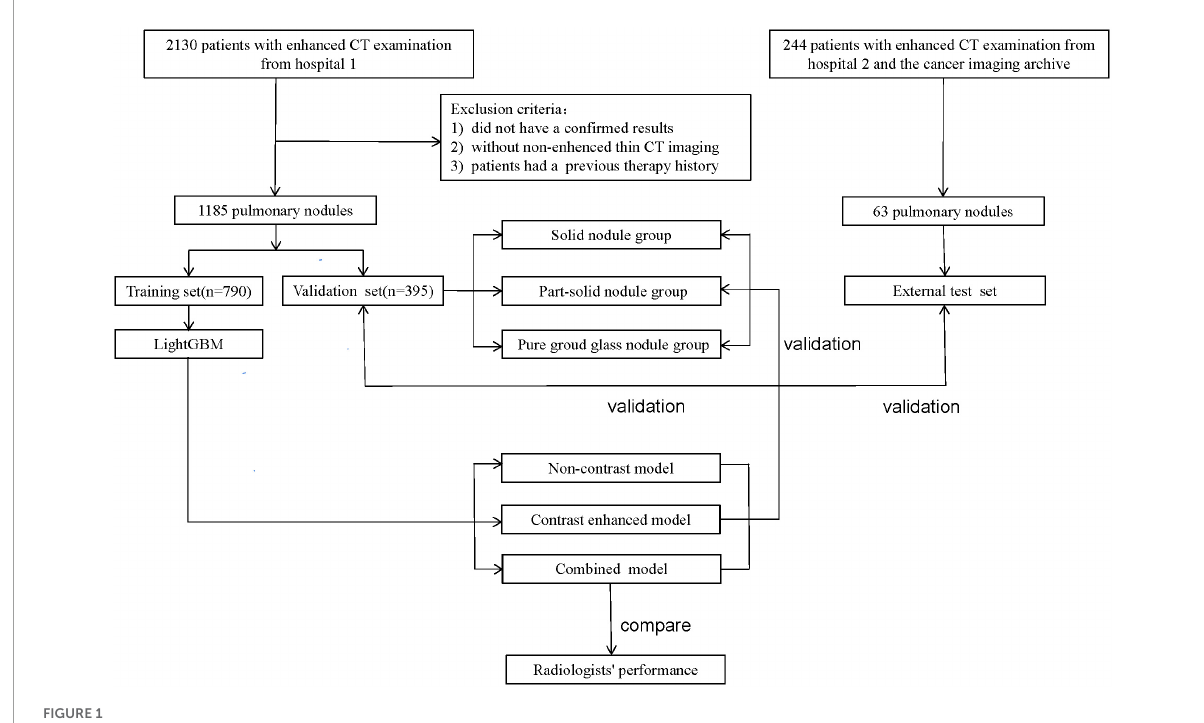
FIGURE1 Workflow of the study.